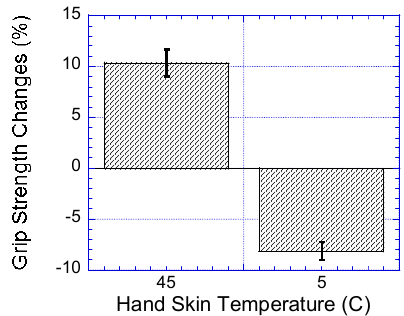
Figure 4. Effect of hand skin temperatures on HS.